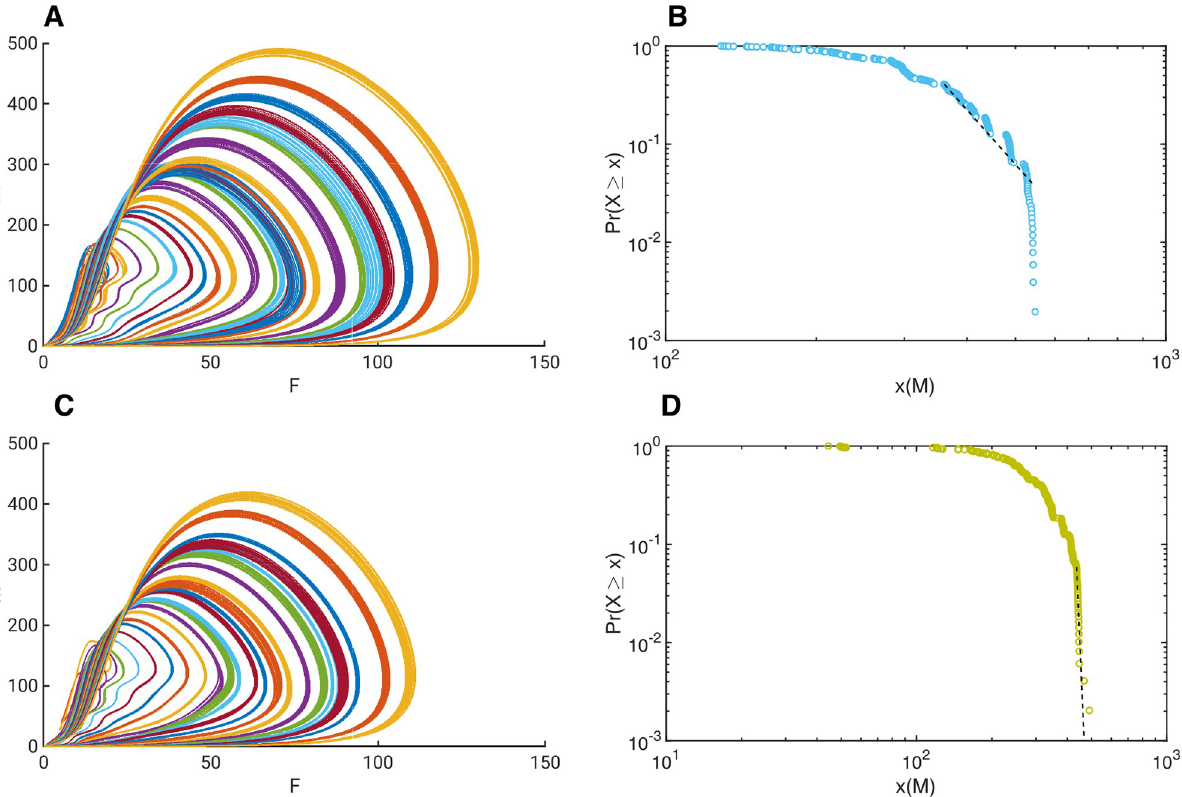
Fig 5. Global positive or negative feedback causing enhancement or loss of power relations. A Total dynamic behaviour of a network of sixteen coupled rate controlled oscillators with global positive feedback. The feedback pushes the total dynamic behaviour to new heights. Each coloured line is one stable oscillation with positive feedback. B Power-law estimation of the maxima of the positive feedback network with the fitted power function (dotted line) superimposed with minimum x ( M ) = 360.24 and slope α = − 6.74. C Total dynamic behaviour of a network of sixteen coupled rate controlled oscillators, differently coloured lines indicate different stable oscillations, with negative global feedback. The negative feedback reduces the behaviour. D Power-law estimation of the maxima of the negative feedback network with the fitted power function (dotted line) superimposed with minimum x ( M ) = 435.69 and slope α = −